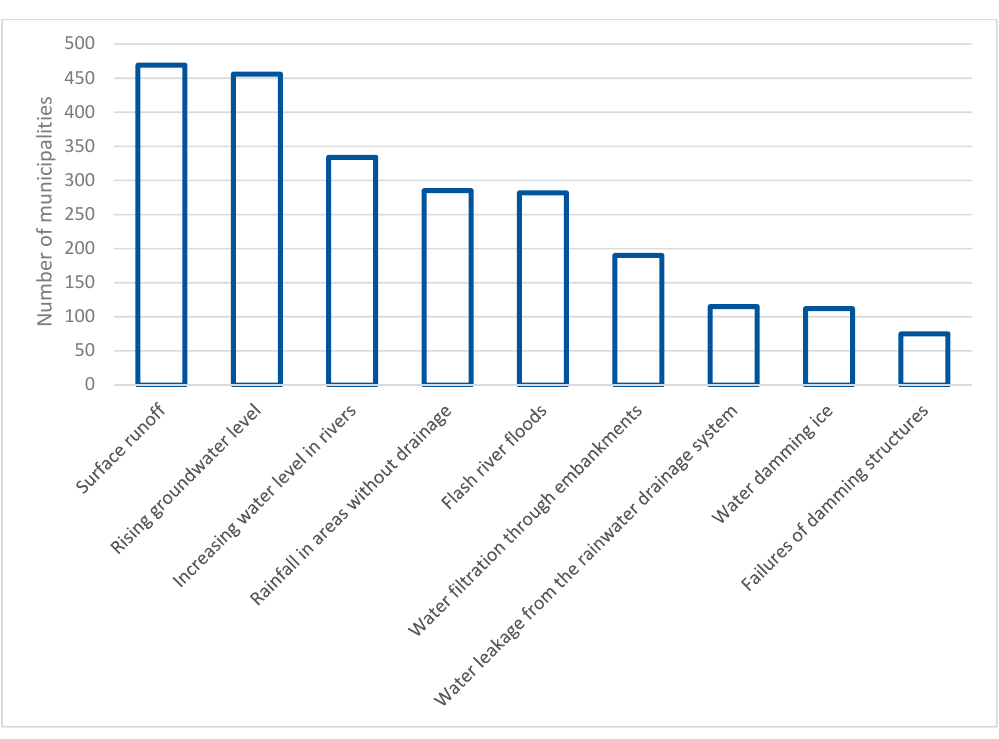
Figure 1. The causes of floods in Poland. Results of a survey of municipalities, own study based on Malopolska Grupa Geodezyjno-Projektowa (MGGP SA), Institute of Meteorology and Water Management-National Research Institute (IMWM-NRI); Analysis of the current flood protection